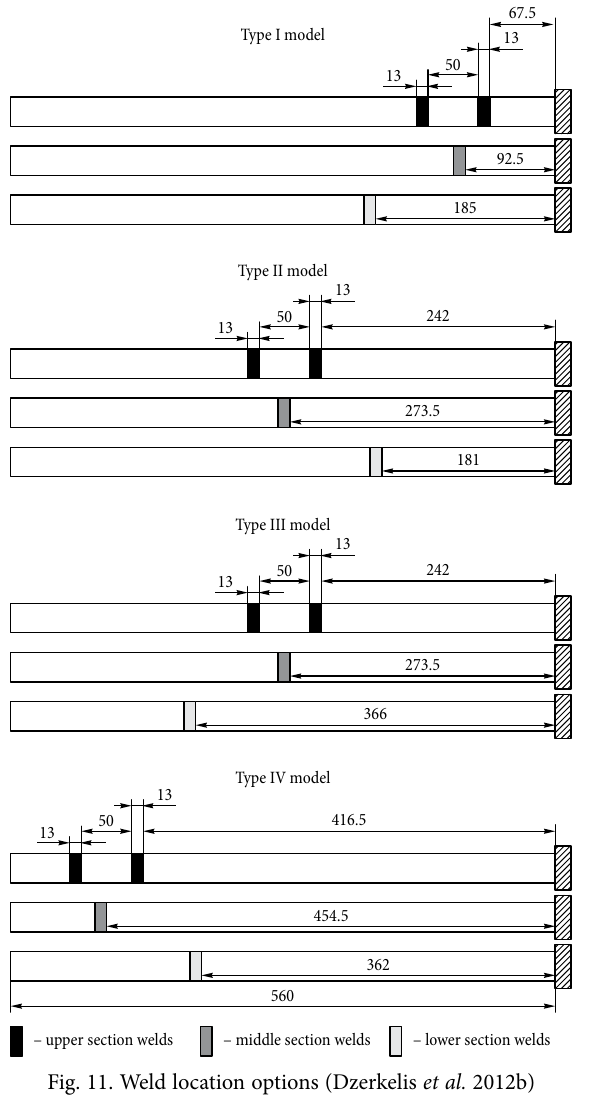
Fig. 11. Weld location options (Dzerkelis et al. 2012b)